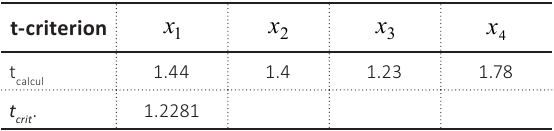
the level of significance (condition 0.05), and n is the number of degrees of freedom. In this